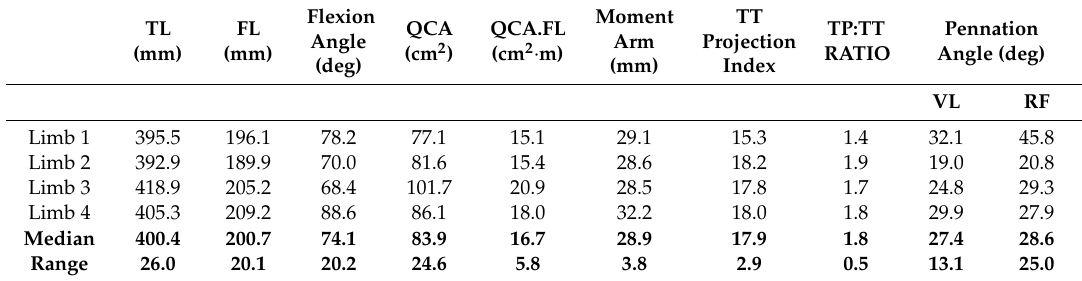
Table 1. Static measurements of the kangaroo stifle.